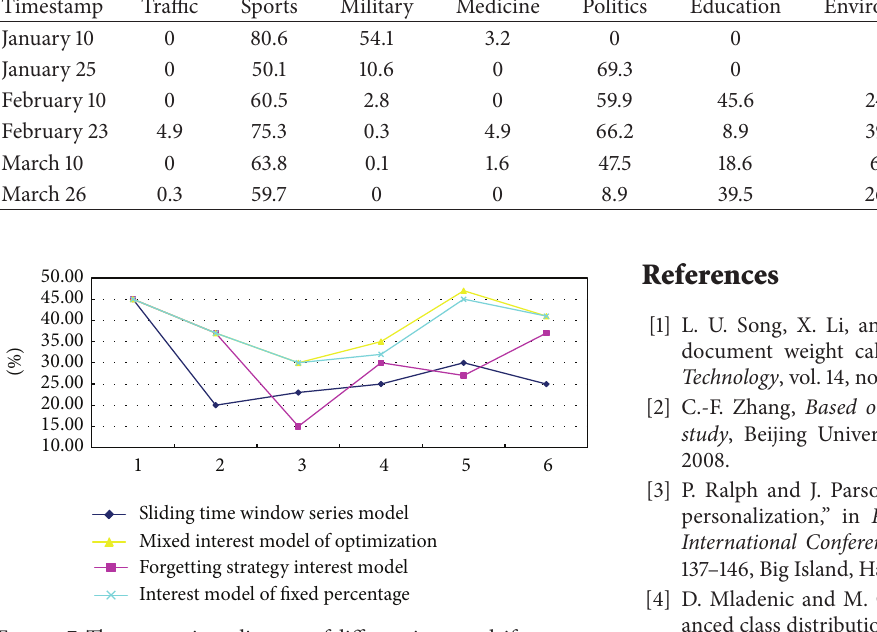
Figure 7: Thecomparison diagram ofdifferent interestdrift strategy experimental